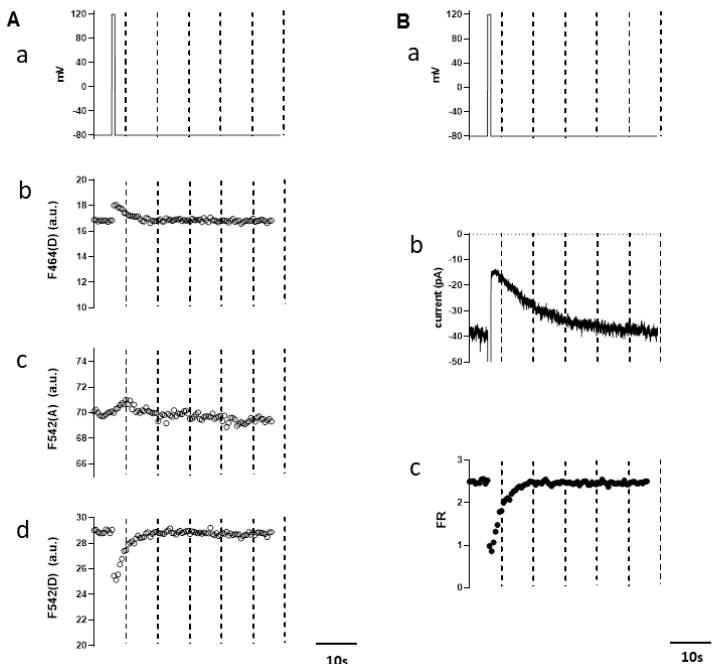
Figure 2. Simultaneous measurement of TRPM4 current and endogenous PI(4,5)P 2 level. Typical example of DrVSP-mediated TRPM4 currents’ change induced by the depolarization and the corresponding FRET changes. ( A ) A 1-s-long depolarizing pulse (from − 60 to 120 mV; (a)) and the changes of the fluorescence intensities (in a.u.) recorded through three different filter settings, F 464(D) (b), F 542(A) (c), and F 542(D) (d). ( B ) A 1-s-long depolarizing pulse (a), the time course of inward TRPM4 current inhibition during the depolarization (b), and that of the FRET ratio (FR) (c). The value of FR is calculated by the 3-cube method (see the Materials and Methods Section and text).